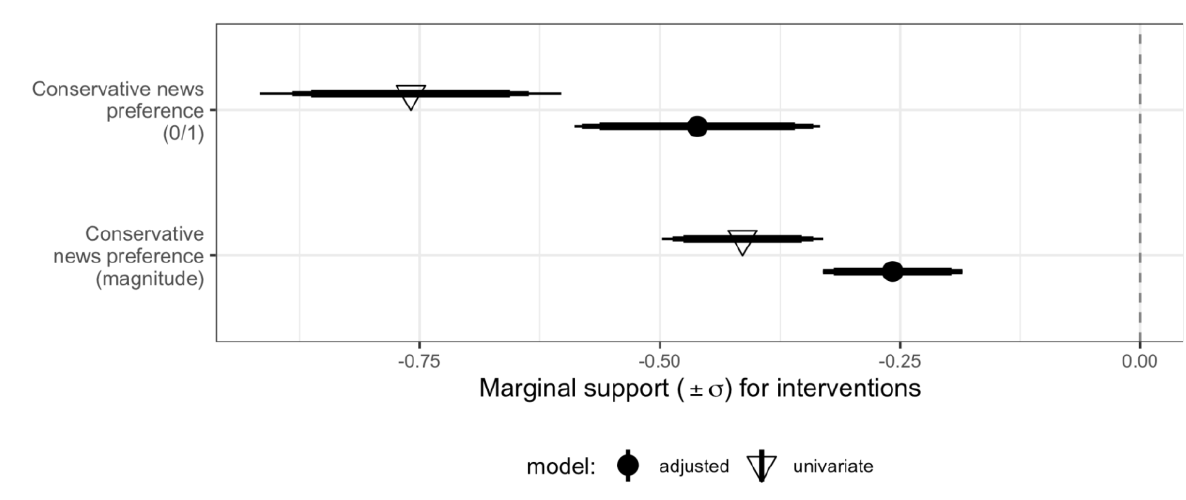
Figure 2. Association between conservative news preference and intervention support (overall index). This plot shows that, with and without covariate adjustment, a standardized increase in conservative news slant in news diet (measured as an average of left/right codings of open-text sources of news as well as pr eference for 9 “anchoring” news sources: Fox News, CNN, Breitbart, Newsmax, Infowars, The Wall Street Journal, The New York Times, The Washington Post, MSNBC) predicts 0.25-0.75 standard deviations of lower support for misinformation interventions.